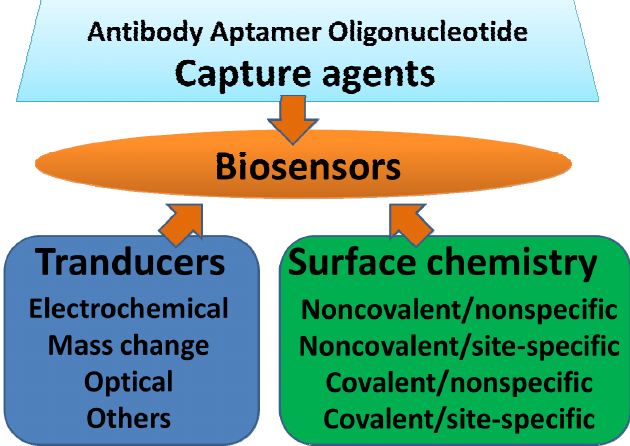
Figure 1. The three ingredients of biosensors.